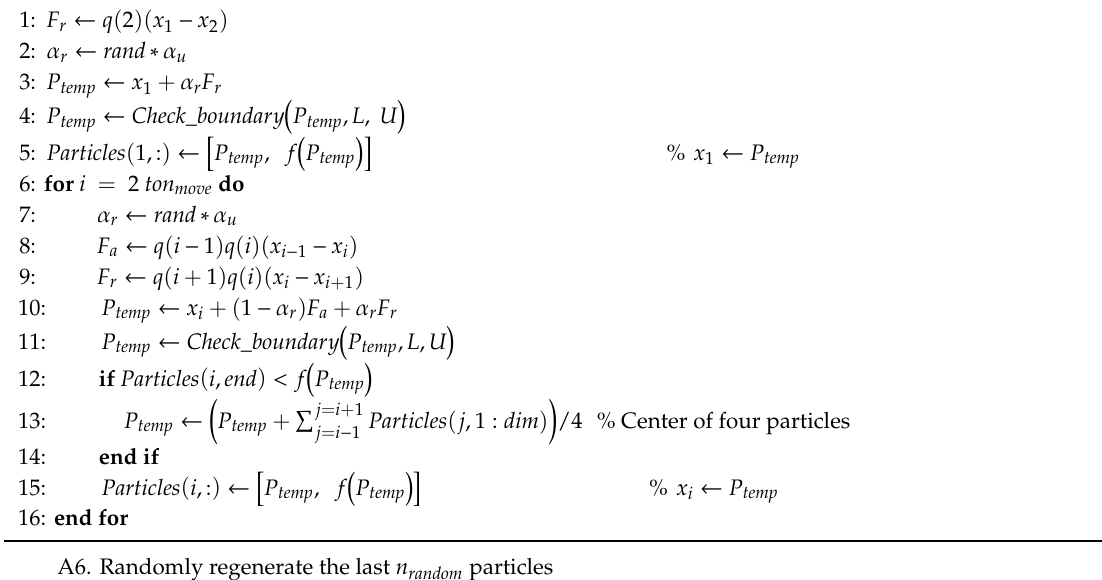
AlgorithmA5. Particles = Move ( f , α u , Particles , q , n move , dim , L , U )